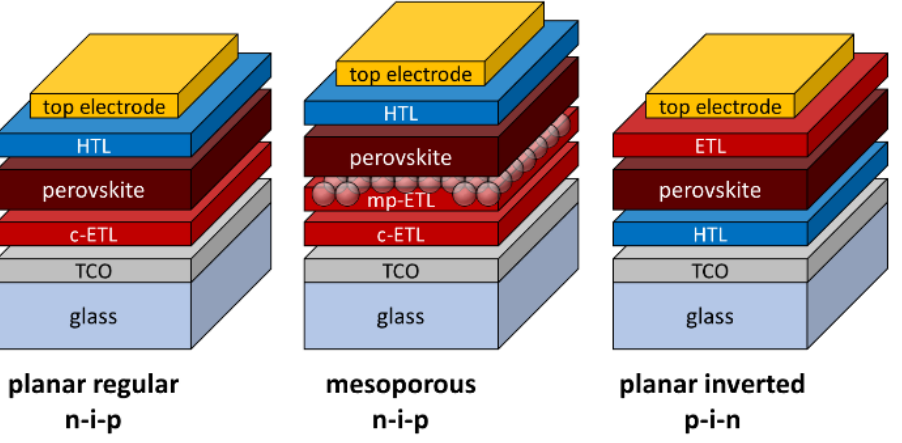
Figure 1. Schemes of the three most common architectures used in PSC technology, from left to right: planar regular (n–i–p), mesoporous (n–i–p) and planar inverted (p–i–n). The devices are